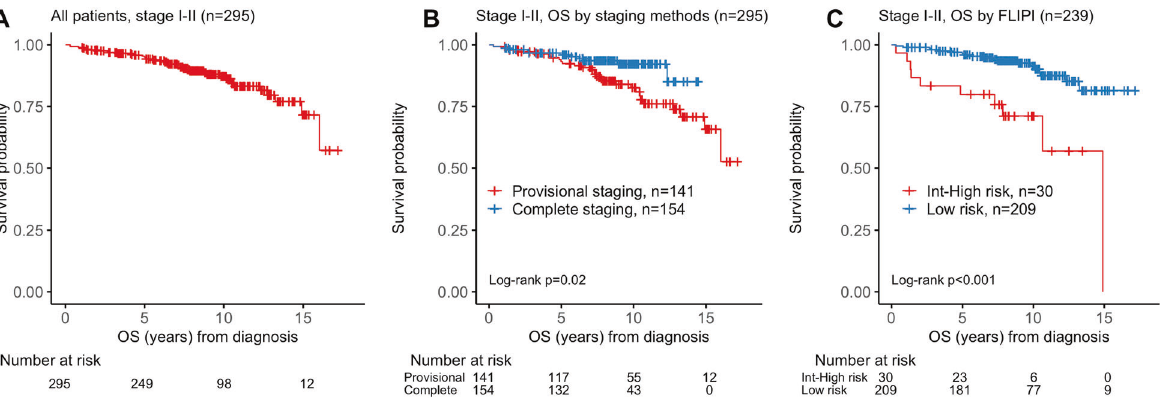
Fig. 2 Kaplan – Meier plots of survival after diagnosis. A Overall survival (OS) for all patients with stage I-II FL ( n = 295). B OS strati fi ed by staging methods ( n = 295). C OS strati fi ed by the FLIPI risk category at diagnosis ( n = 239).